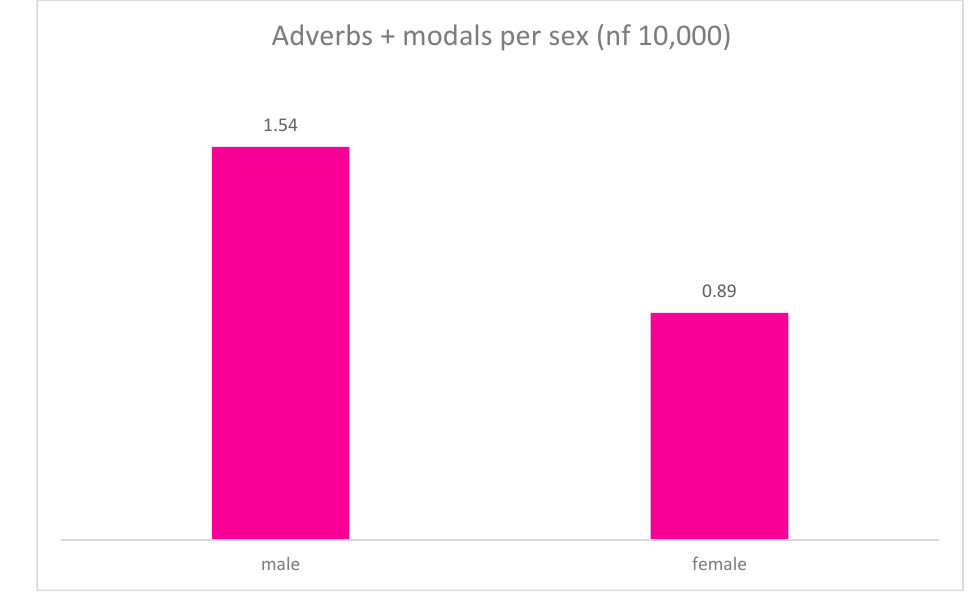
Figure 4. Use of adverbs with modals per sex.